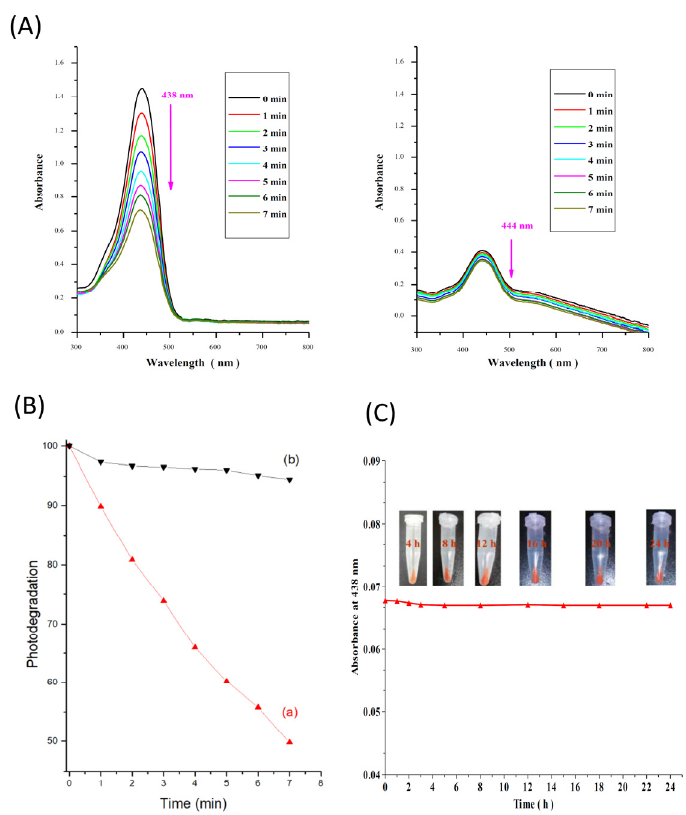
Figure 6. Photostability studies of Cur, ( A ) UV-vis spectrum analysis of absorption bands of free Cur and IBN-1-Cur-CP samples by UV light irradiation with time up to 7 min in DMSO: H 2 O (1:1 v / v ) medium; ( B ) The samples of (a) free Cur ( λ max at 438 nm) and (b) IBN-1-Cur-CP ( λ max at 444 nm) irradiation under UV light up to 7 min, calculating the percentage photo-degradation rate; and ( C ) UV-vis absorbance values of Cur showing the leakage of Cur content from the IBN-1-Cur-CP formulation in cell culture medium for 24 h.